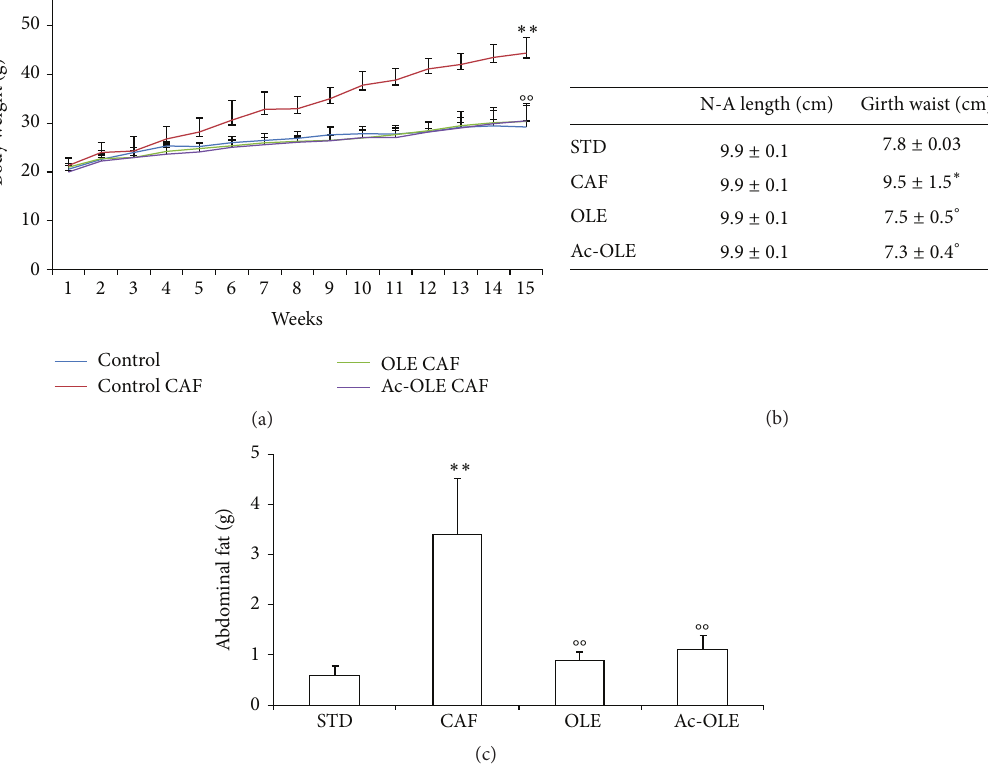
Figure 1: Effects of Ole and Ac-Ole on body weight and girth waist. (a) Body weight and (b) N-A length and girth waist are relative to the end of treatment (15 weeks). (c) Abdominal fat tissue weight. Values are mean ± SD. ∗ 𝑃 < 0.05 and ∗∗ 𝑃 < 0.01 compared to mice fed with std diet; ∘ 𝑃 < 0.05 and ∘∘ 𝑃 < 0.01 compared to mice fed with caf